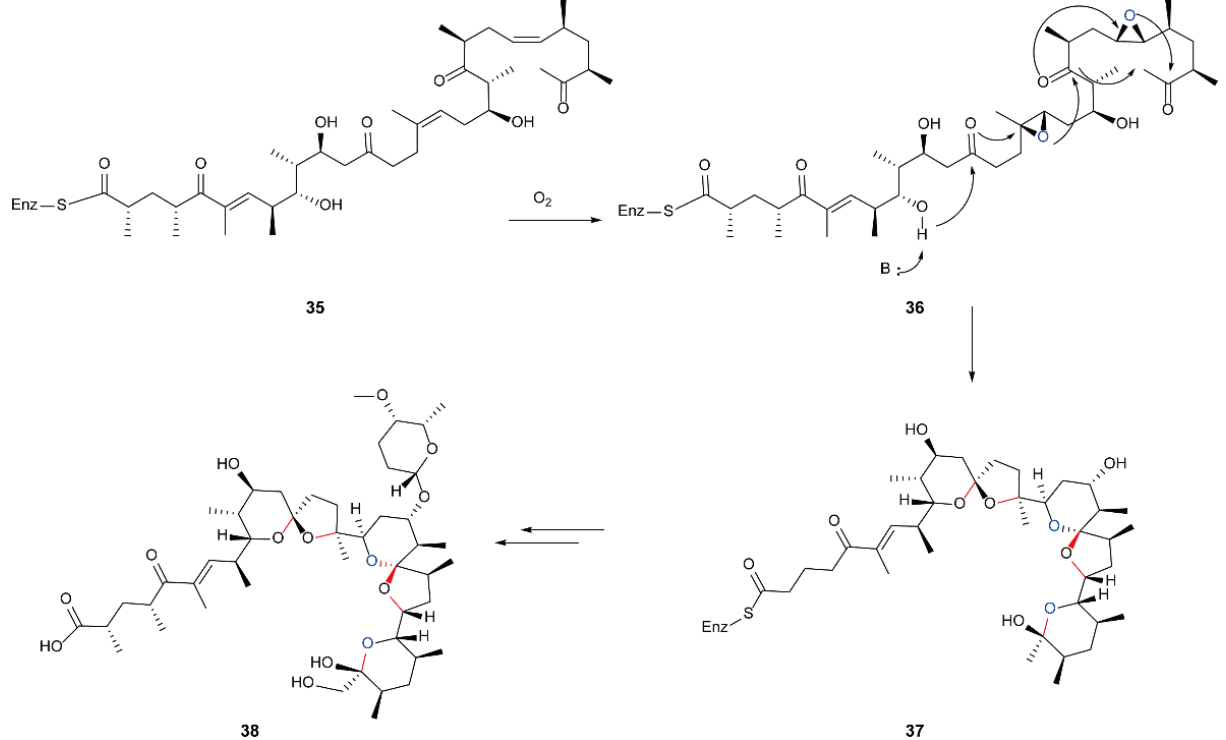
Scheme 11 . Mechanism of Polyether Formation in Nanchangmycin